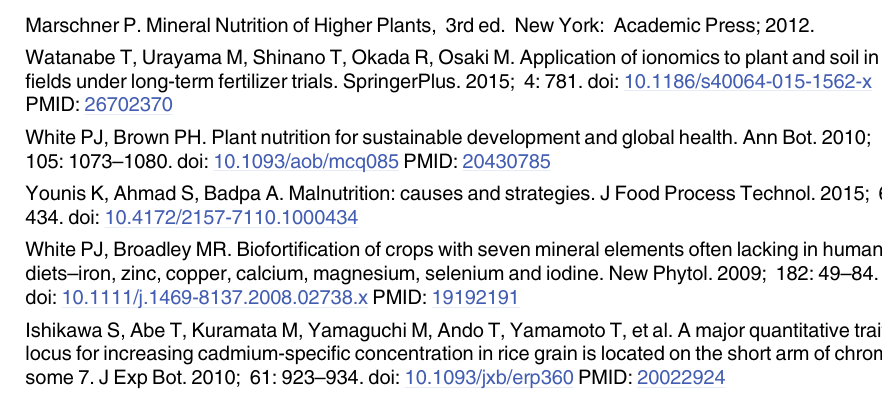
S1 Table. Chemical properties of the field soils used in this study. S2 Table. Average mineral concentration (mg g -1 ) of each element in leaves of Komatsuna4 in 2011 and 2012. S3 Table. Mineral concentration (mg g -1 ) in edible or nonedible part of each